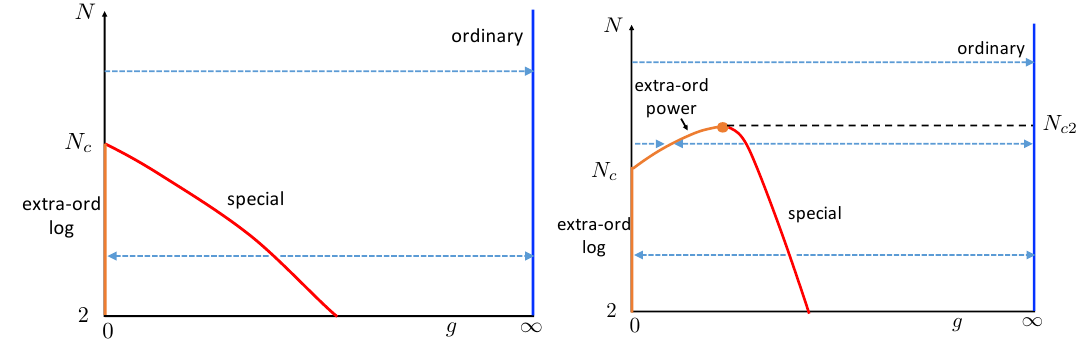
Figure 4: Conjectured RG flows as a function of N in d = 3. Left - scenario I. Right - scenario II. Blue dashed arrows indicate the direction of RG flow. Black dashed lines are guide to eye.